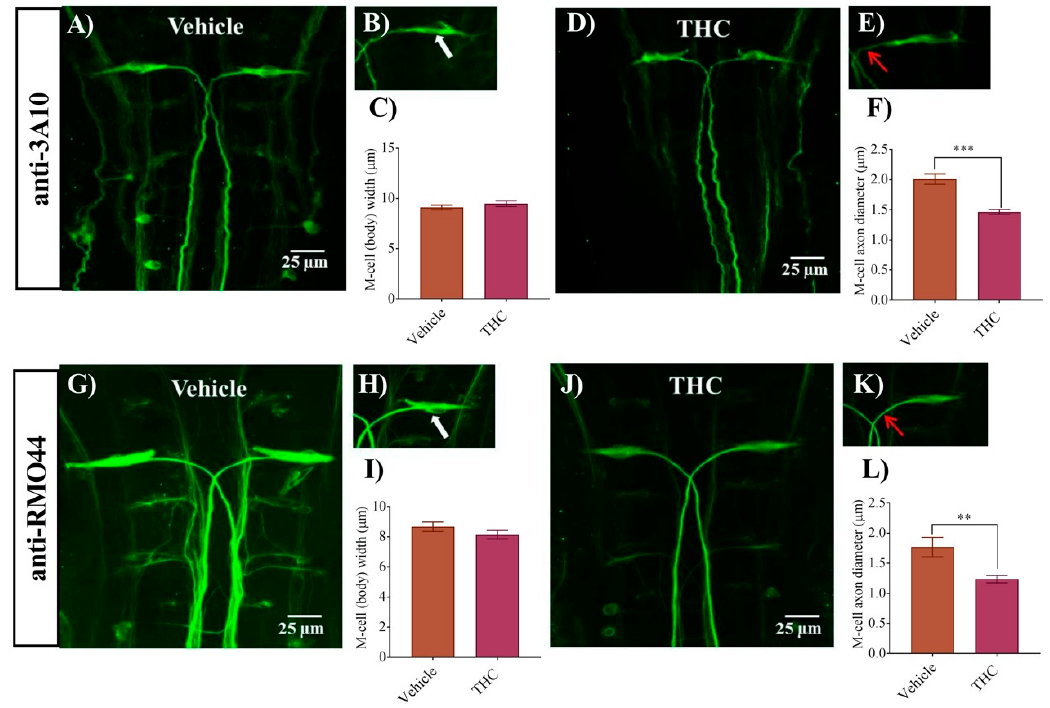
Figure 1. ∆ 9 -Tetrahydrocannabinol (THC) exposure reduces M-cell axonal diameter. ( A , G ) Immunolabeling of M-cells with anti-3A10 and anti-RMO44 in a vehicle-treated embryo; ( B , H ) Higher magnification of M-cell body and axon of vehicle-treated embryos. White arrow shows the cell body of the M-cell. ( C , I ) Bar graph of the width of an M-cell body in vehicle and THC treated embryos. ( D , J ) Immunolabeling of M-cells with anti-3A10 and anti-RMO44 in a THC-treated (6 mg / L) embryo; ( E , K ) Higher magnification of M-cell body and axon of a THC-treated embryo. Red arrow points to the proximal axon immediately anterior to the decussation point. ( F , L ) Bar graph of the diameter of M-cell axons slightly anterior to the decussation point in vehicle and THC-treated embryos. ** Significantly di ff erent from vehicle control, p < 0.005. *** significantly di ff erent from vehicle control, p < 0.001.